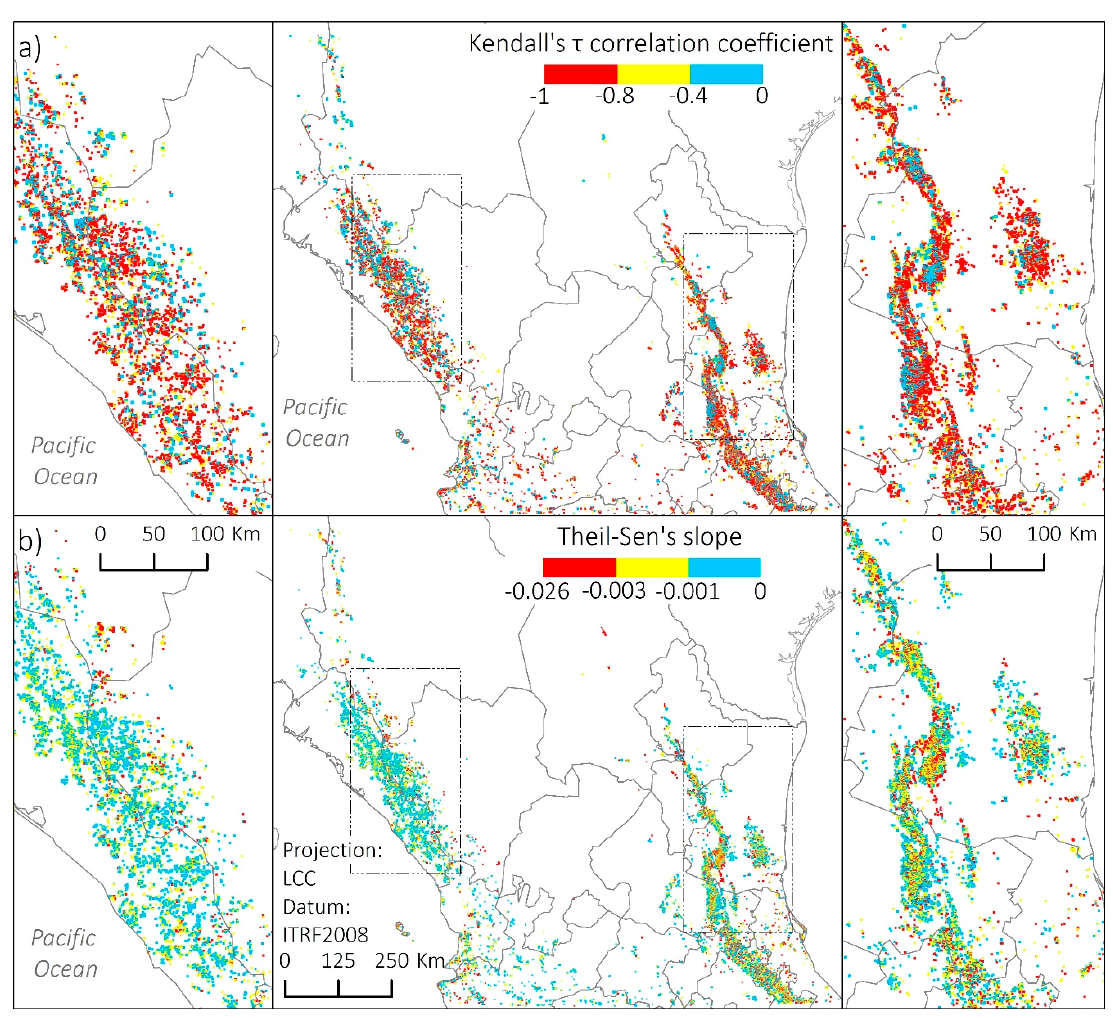
Figure 5. Strength ( a ) and magnitude ( b ) of negative trends at 95% confidence level, 2002–2017. *The pixel size has been exaggerated for visualization proposes.